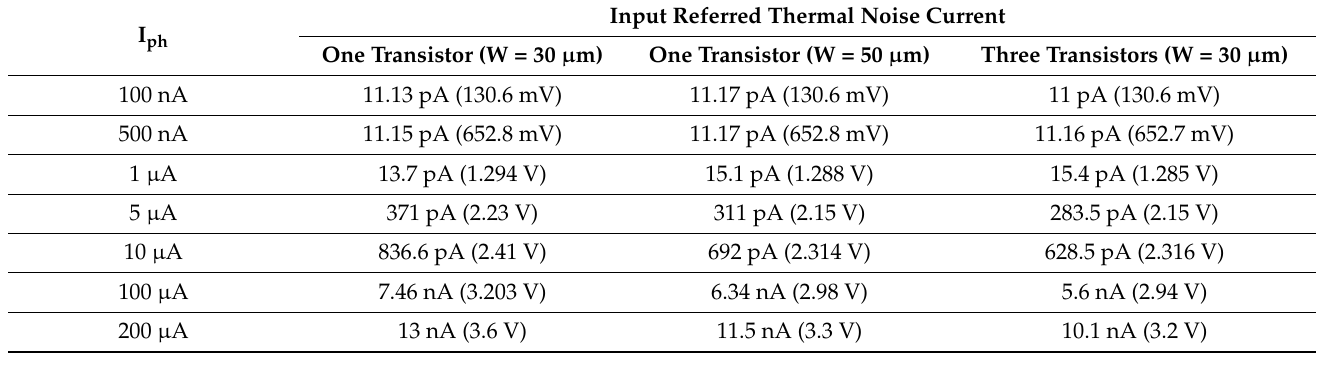
Table 4. Comparison between the one transistor and 3T-BCL topologies.